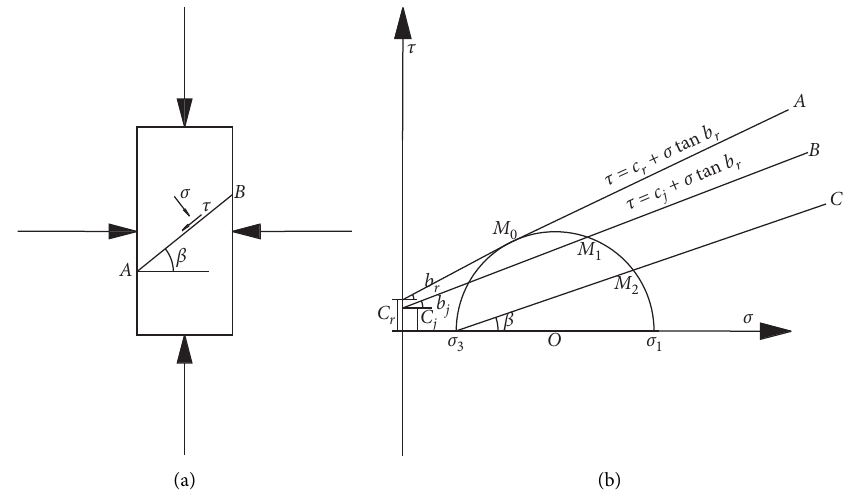
Figure 2: Mechanical analysis of rock with bedding